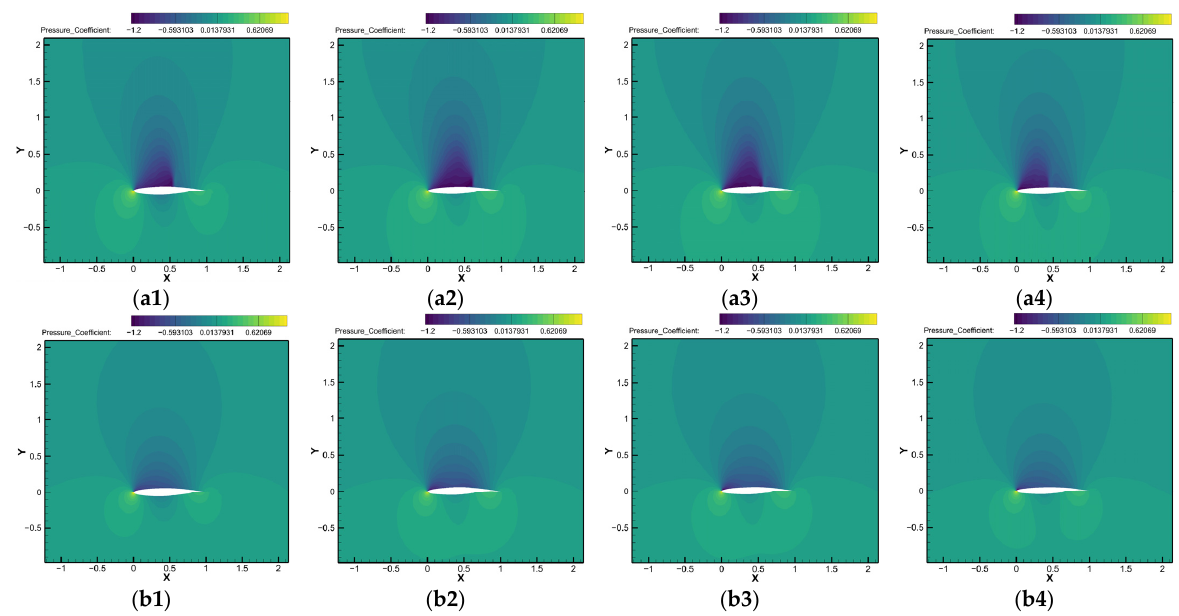
Figure 12. Comparison of pressure coefficient distribution between optimized airfoil and baseline.